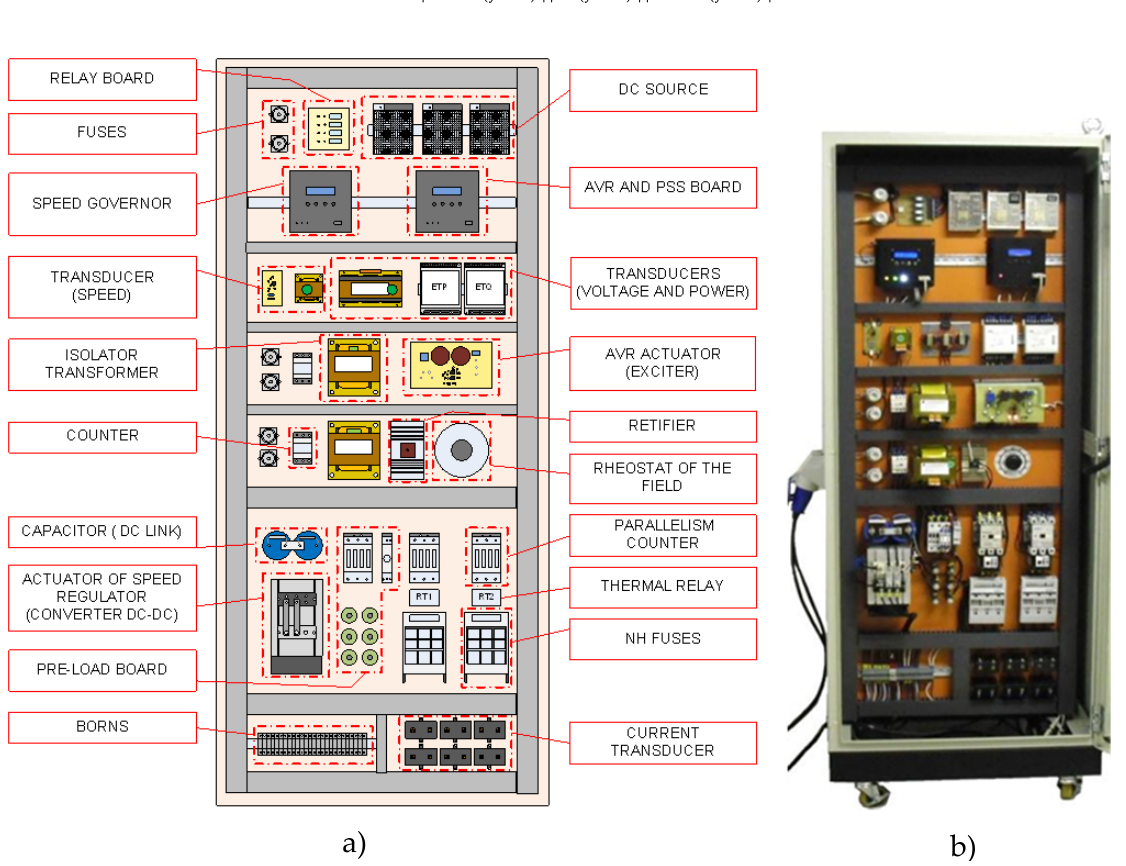
Figure 2. ( a ) Layout; and ( b ) control panel developed. Figure 1. ( a ) Layout; and ( b ) control panel